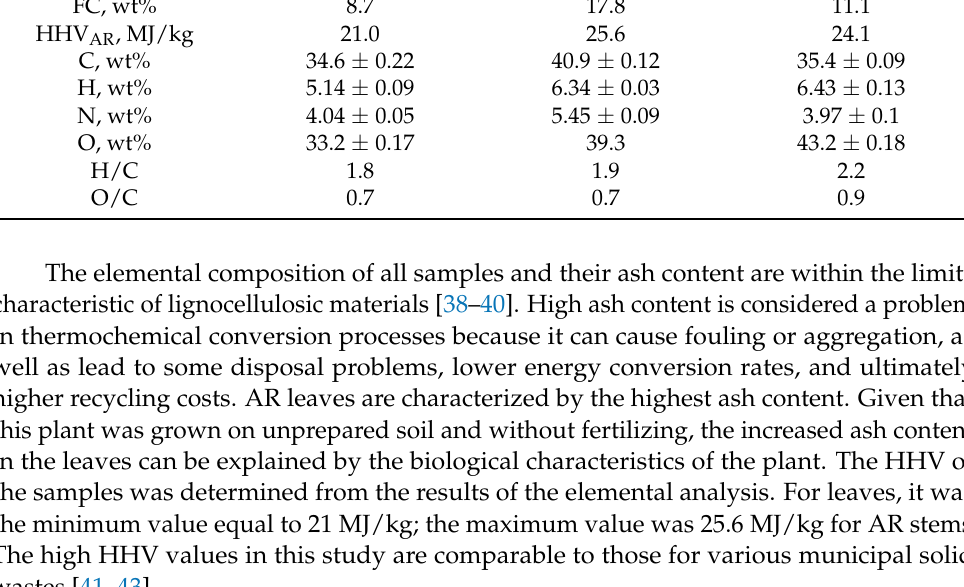
Table 1. Results of the proximate and ultimate analyses of the AR biomass samples. Parameter Leaves Inflorescences Stems Moisture, wt% 7 ± 0.01 7 ± 0.01 7 ± 0.01 VM, wt% 68.3 ± 0.4 74.2 ± 0.7 77.9 ± 0.8 Ash, wt% 23 ± 0.02 8 ± 0.01 11 ± 0.01 FC, wt% 8.7 17.8 11.1 HHV AR , MJ/kg 21.0 25.6 24.1 C, wt% 34.6 ± 0.22 40.9 ± 0.12 35.4 ± 0.09 H, wt% 5.14 ± 0.09 6.34 ± 0.03 6.43 ± 0.13 N, wt% 4.04 ± 0.05 5.45 ± 0.09 3.97 ± 0.1 O, wt% 33.2 ± 0.17 39.3 43.2 ± 0.18 H/C 1.8 1.9 2.2 O/C 0.7 0.7